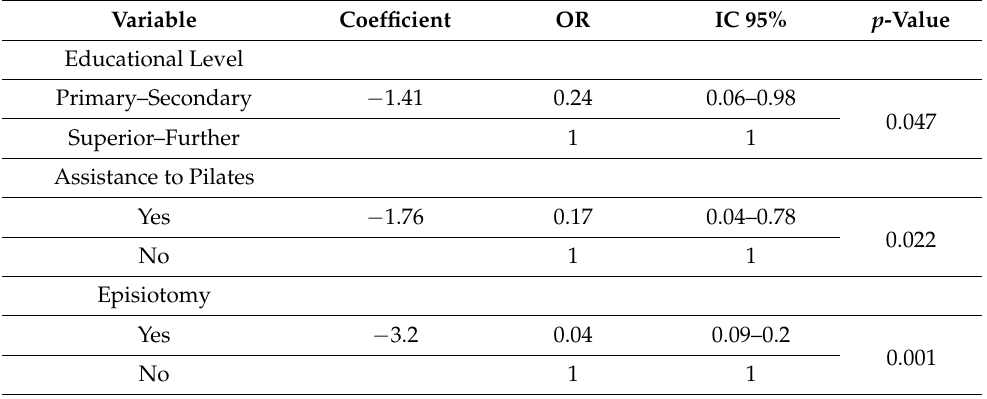
Table 5. Binary logistic regression adjusted for age, level of education, episiotomy realization and assistance to Pilates sessions and presence of tearing as outcome variable 1